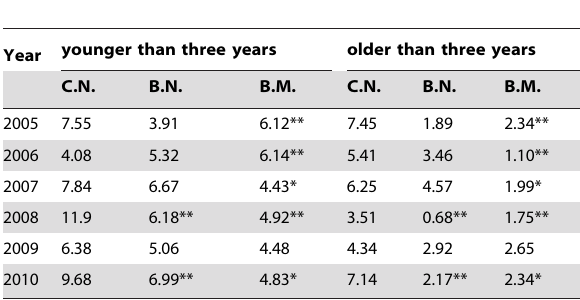
Table 4. Prevalence (%) of S. japonicum infection in bovines of different